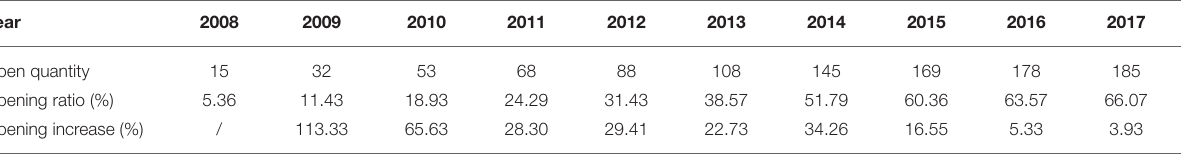
TABLE 2 | Opening of high-speed rail from 2008 to 2018.